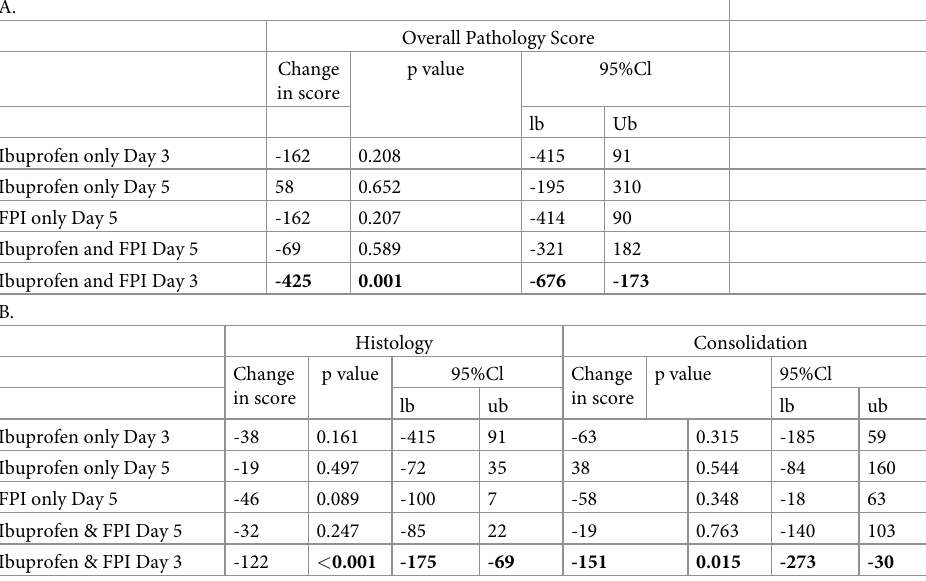
Table 4. A. Results for multilevel models for the overall pathology score. B. Results for multilevel models for the histo- logical and consolidation components of the overall pathology score. A.